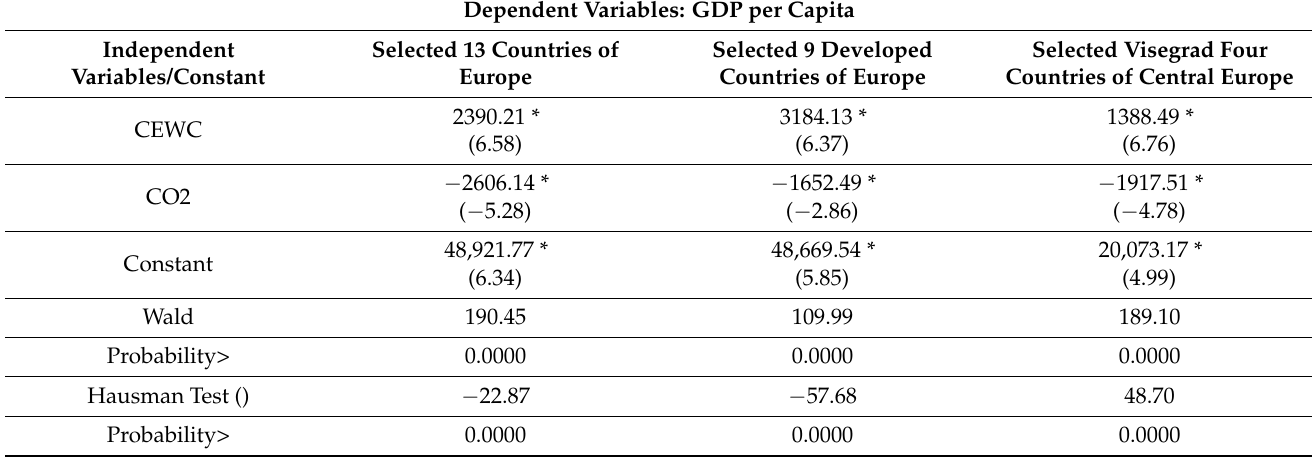
Table A1. The regression model with random effect